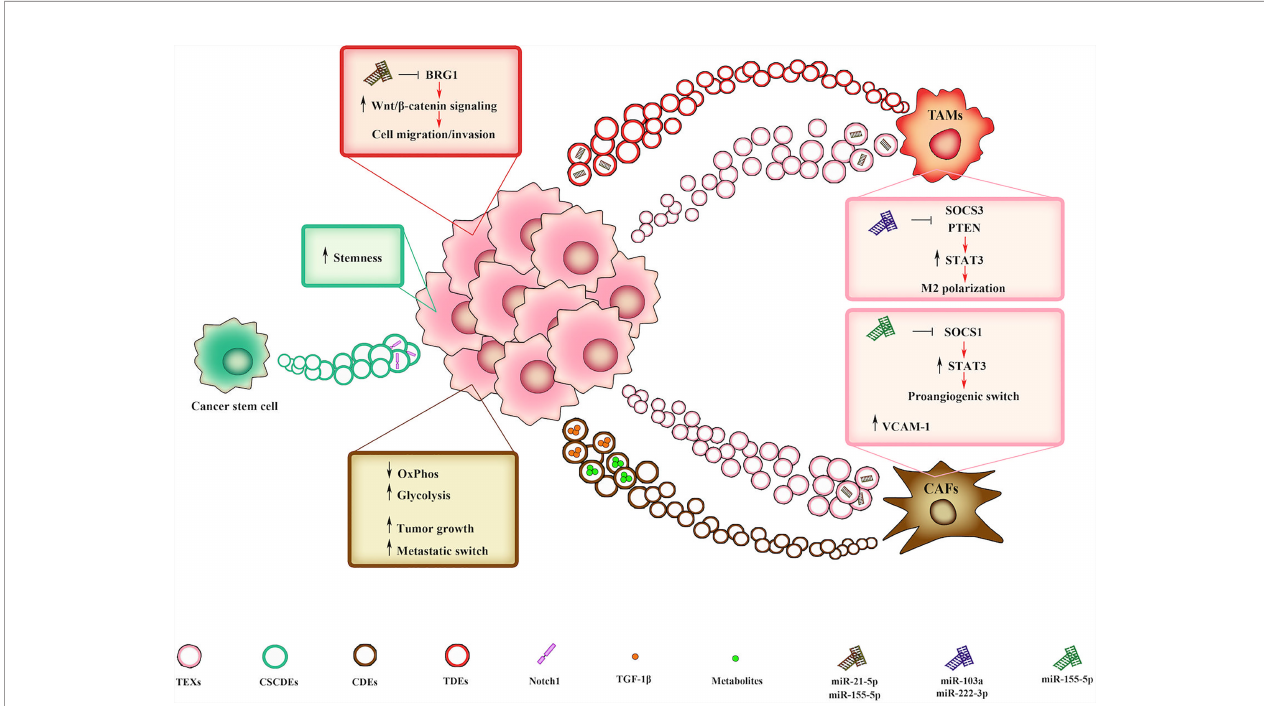
FIGURE 2 | EV-mediated interplay within the TME mediates tumor progression. CAF-derived exosomes (CDEs) promote either metabolism deregulation or metastatic switch in tumor cells by delivering intact metabolites or TGF- b , respectively. TAMs-derived exosomes (TDEs) loaded with miR-21-5p and miR-155-5p can promote cell migration and invasion by downregulating BRG1 gene, thus sustaining Wnt/ b -catenin signaling. CSCs-derived EVs (CSCDEs) confer stemness traits to recipient cells by delivering notch receptor 1 (notch1) protein. In turn, tumor-derived exosomes (TEXs) induce CAF transformation and macrophage M2 polarization by delivering miR-155-5p, miR-103a and miR-222-3p, that in turn affect STAT3